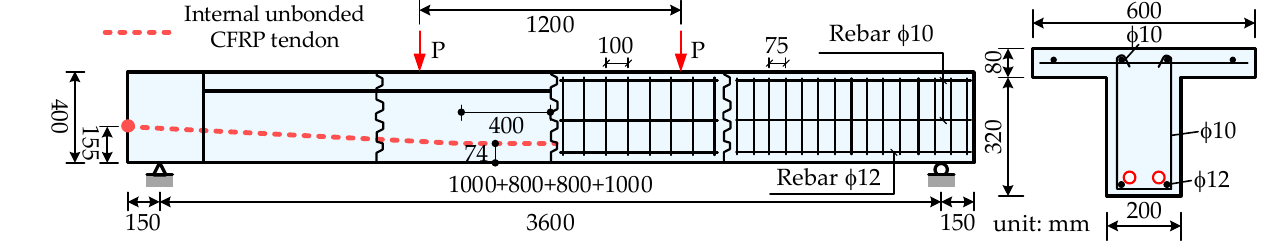
Figure 10. Structural dimensions of specimens C2 and C4 (unit: mm). Table 1. Properties of material used in specimens C2 and C4.